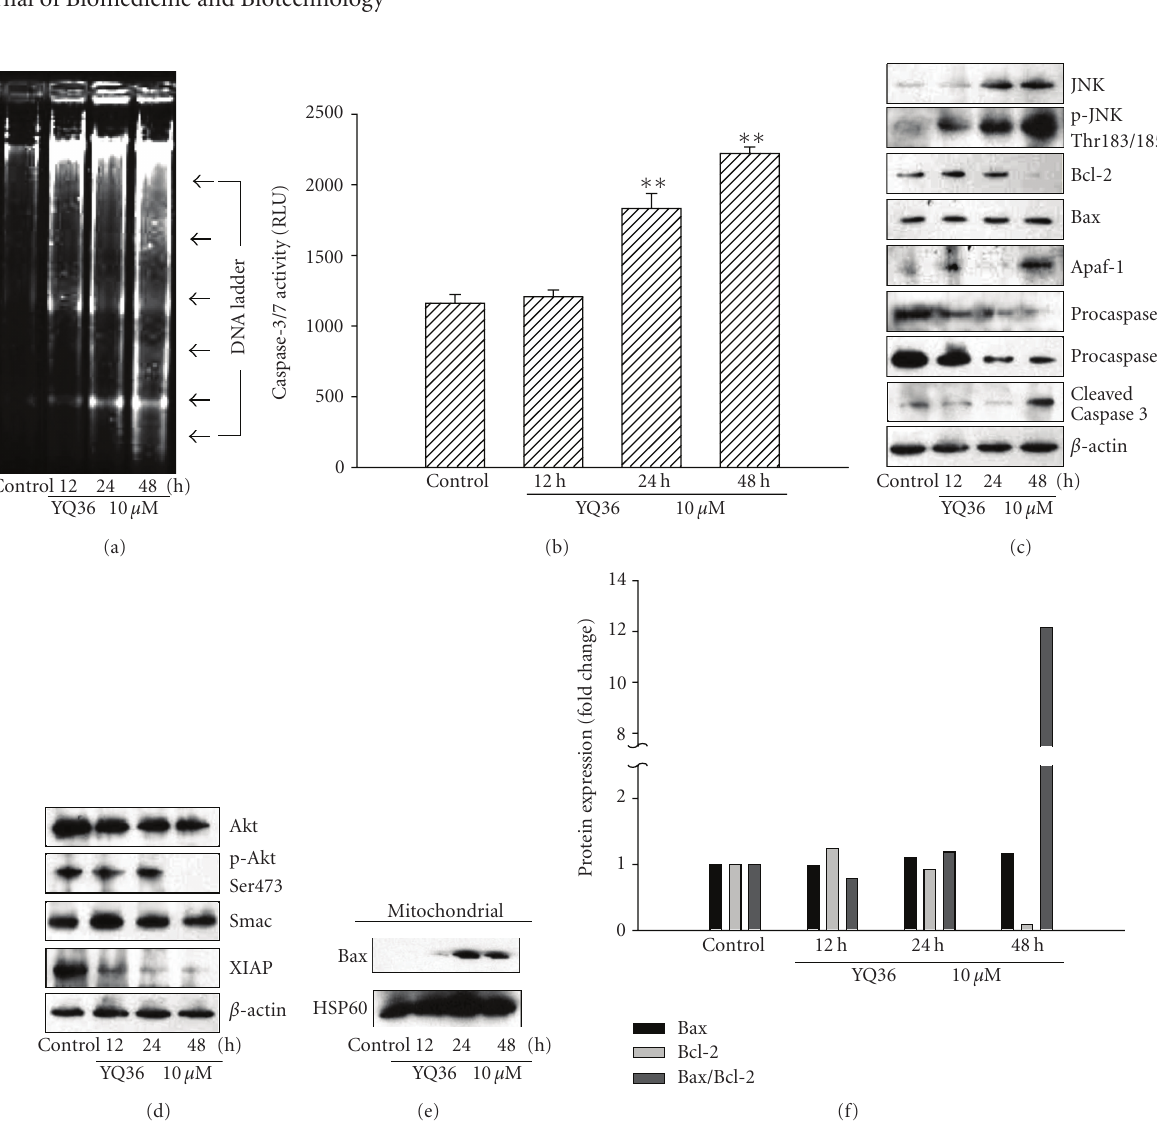
Recent research demonstrated that resistance